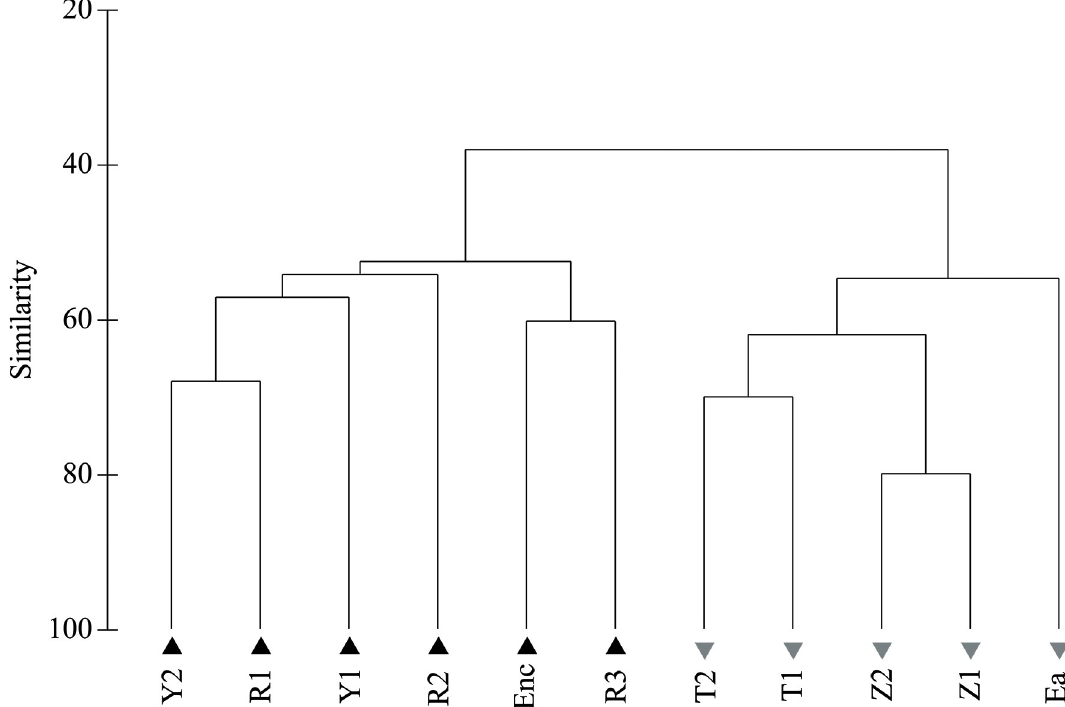
Fig 2. Hierarchical cluster. Hierarchical cluster analysis (UPGMA) based on the composition of the macroinvertebrate community of each site. The resultant groups are identified with black triangles (group 1) and grey inverted triangles (group 2).